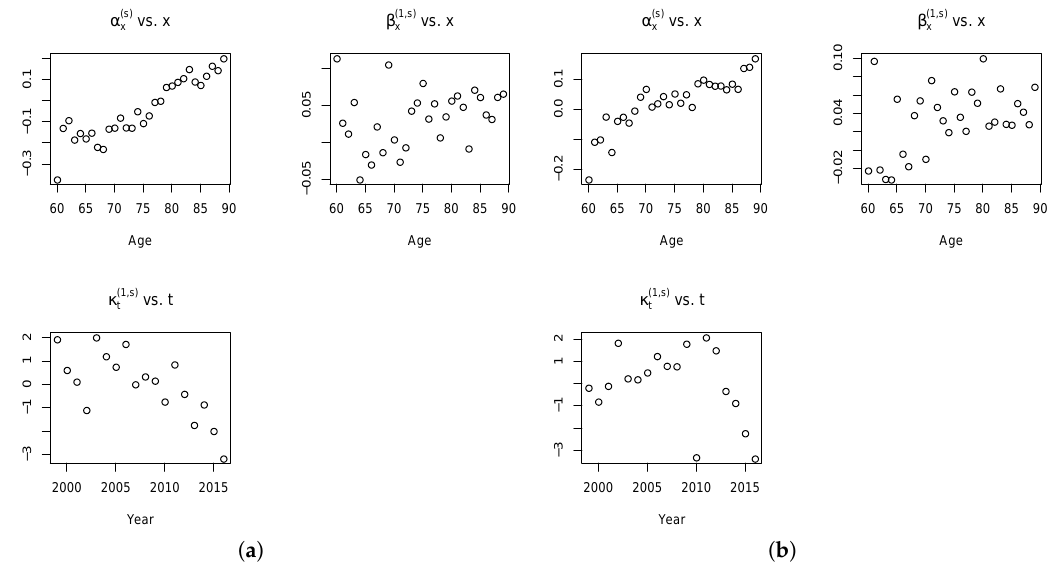
Figure 7. Estimated Spread parameters of the RH–LC model for ( a ) female Maltese population and ( b ) male Maltese population.